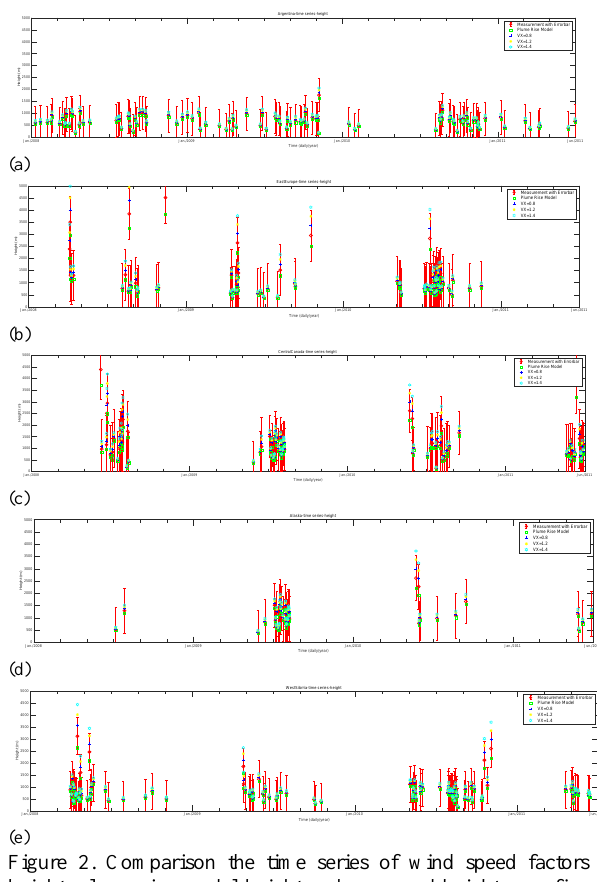
(e) Figure 2. Comparison the time series of wind speed factors height, plume rise model height and measured height over five best-fit regions (a) Argentina; (b) East Europe; (c) Central Canada; (d) Alaska; (e) West